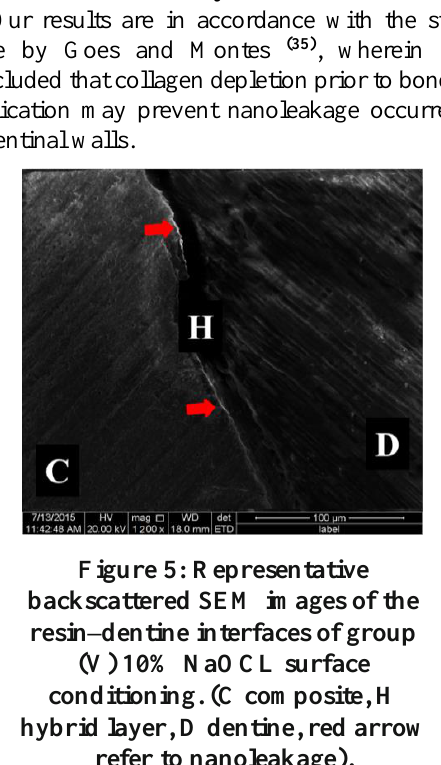
Figure 4: Representative backscattered SEM images of the resin–dentine interfaces of group (IV) only acid surface conditioning. (C composite, H hybrid layer, D dentine, red arrow refer to nanoleakage).